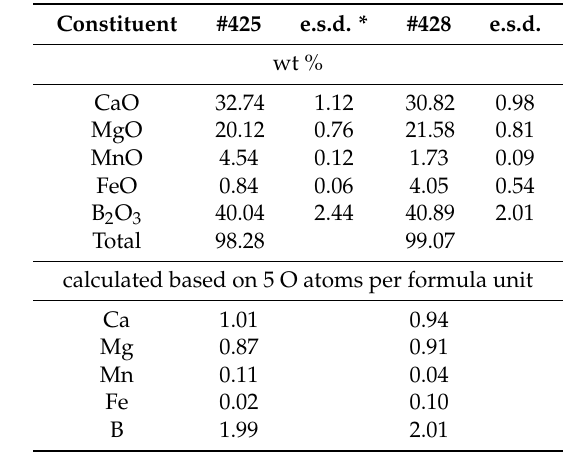
Table 1. Chemical composition of kurchatovite from Solongo (#425) and clinokurchatovite from Sayak-IV